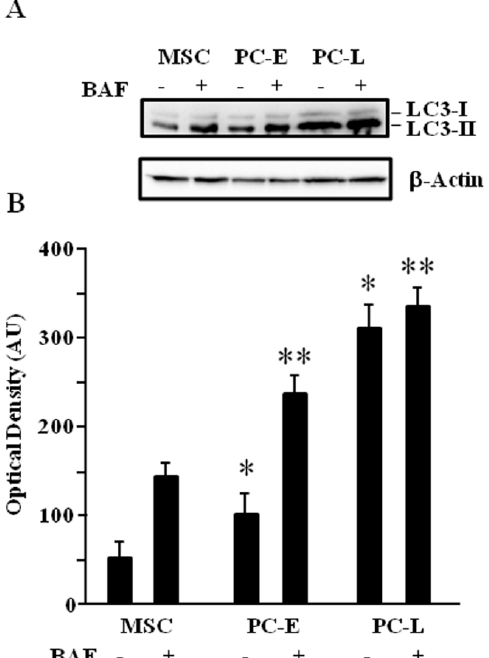
Figure 3. LC3-II increases in melanoma cells undergoing progressive differentiation revealing autophagic flux up-regulation. ( A ) MSC, PC-E and PC-L were cultured in the presence or absence of the lysosomal degradation inhibitor bafilomycin A1 (BAF). They were lysed and protein samples were subjected to Western blot analysis. LC3-II increase in differentiated melanoma cells, although evident in either case, is more evident after BAF treatment, thus demonstrating autophagic flux up-regulation as function of time of differentiation. Western blot panel is representative of three independent experiments. β -Actin was used as a loading control; ( B ) densitometric analysis of LC3-II relative to β -Actin in three independent experiments is presented in the graph as the mean ± s.d. expressed as AU. BAF-treated MSC vs. untreated MSC display significant increase ( p ≤ 0.05). Similarly, BAF treated PC-E vs. untreated PC-E display significant increase ( p ≤ 0.05). ** indicates p ≤ 0.05 in BAF-treated PC vs. BAF-treated MSC. * indicates p ≤ 0.05 in untreated PC vs. untreated